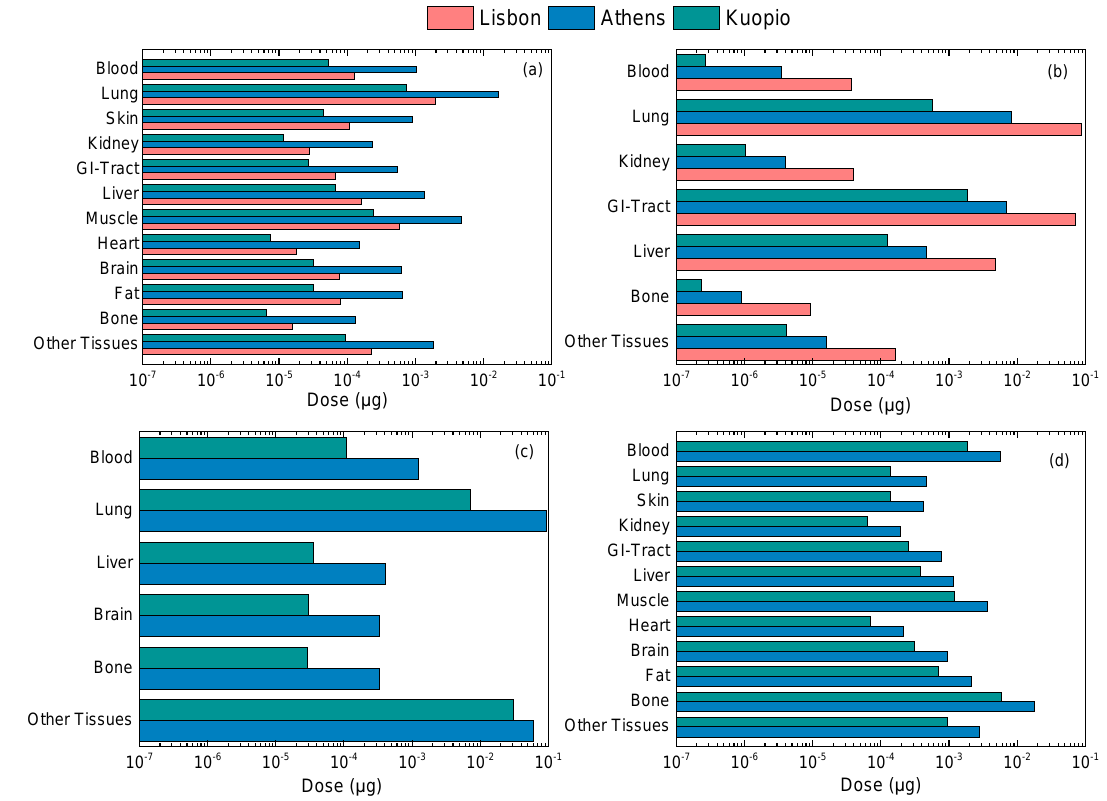
Figure 6. Internal dose (μg) of metals ( a ) As, ( b ) Cr ( c ) Mn and ( d ) Pb at different tissues in the human body estimated for an adult male at the end of one day.